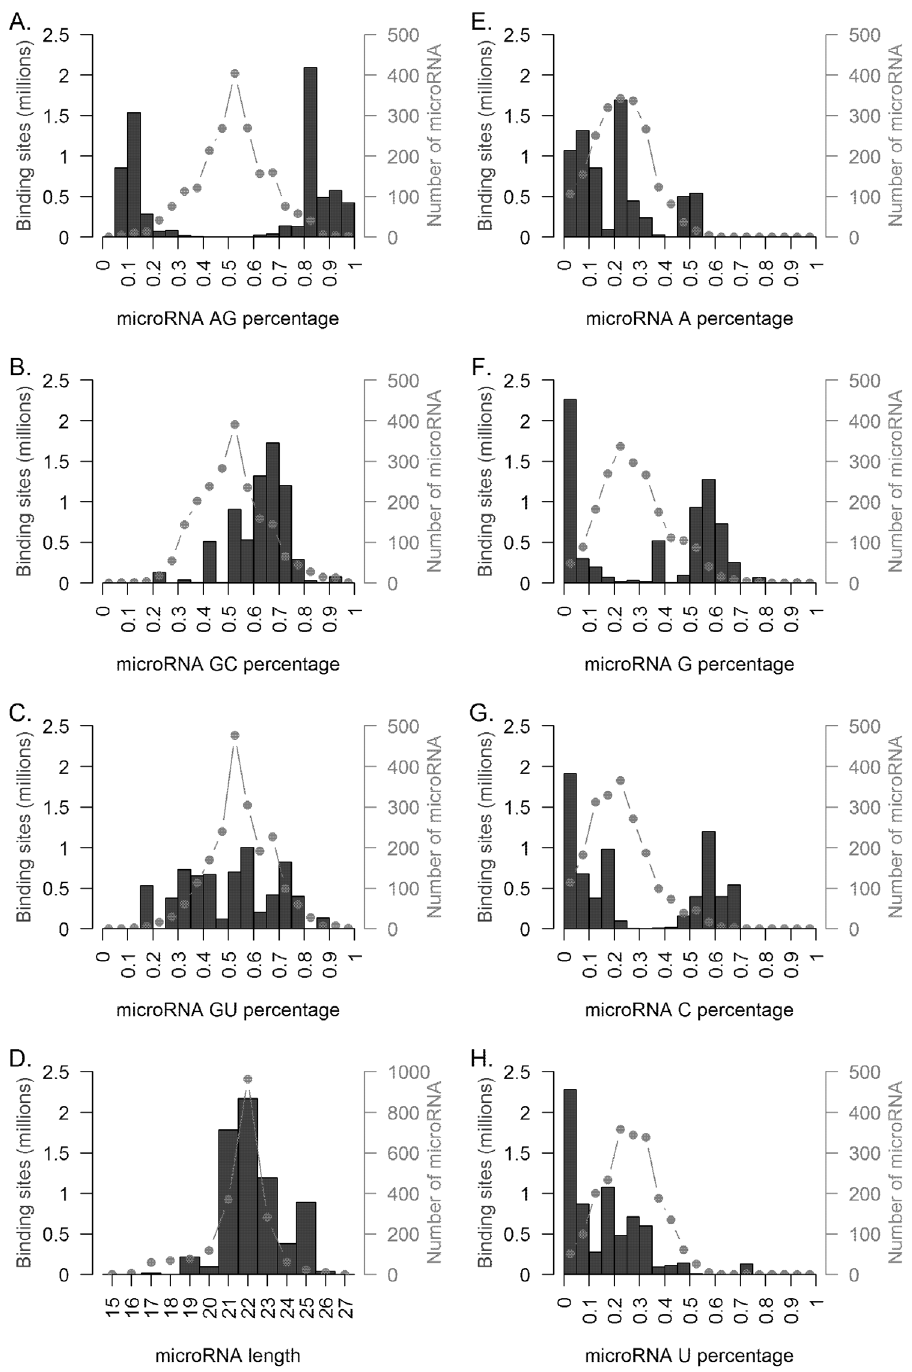
Fig 2. Characteristics of triplex forming microRNA. The top 1 percent of Homo sapiens triplex interactions (grades 1 – 4) were characterized by (A-C) microRNA dinucleotide frequency, (D) microRNA length, and (E-H) single nucleotide frequency, and compared to these same characteristics for all human microRNAs. The percentage of purine content was the largest discriminating factor in predicting triplex formation, with the majority of binding sites having greater than 75% purine or pyrimidine content (A). Higher GC content (B), length between 21 and 25 nucleotides (D), greater than or less than average G or C content (F and G), and lower than average U content (H) also predicted triplex